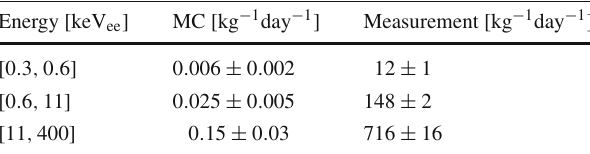
Table 13 Expected count rate by reactor neutrons inside the CONUS shield for the maximum reactor thermal power of 3.9GW compared to the measured background during reactor OFF